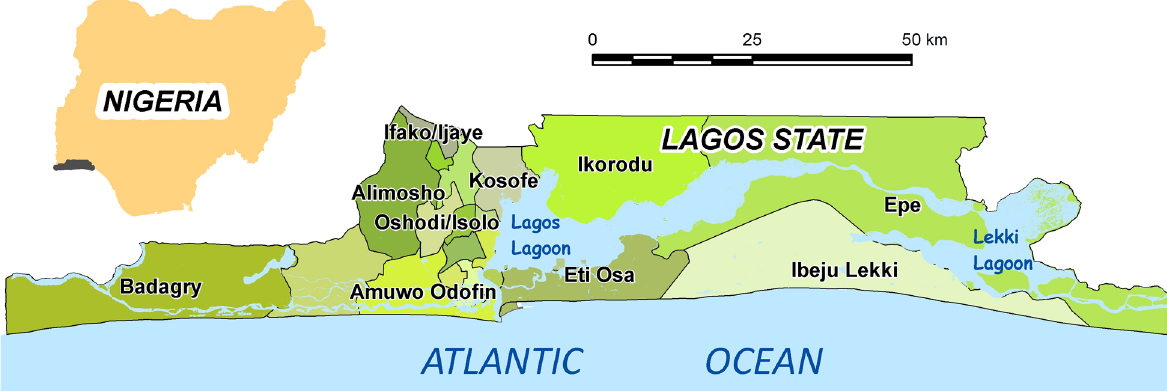
fig. 1. Map of the study